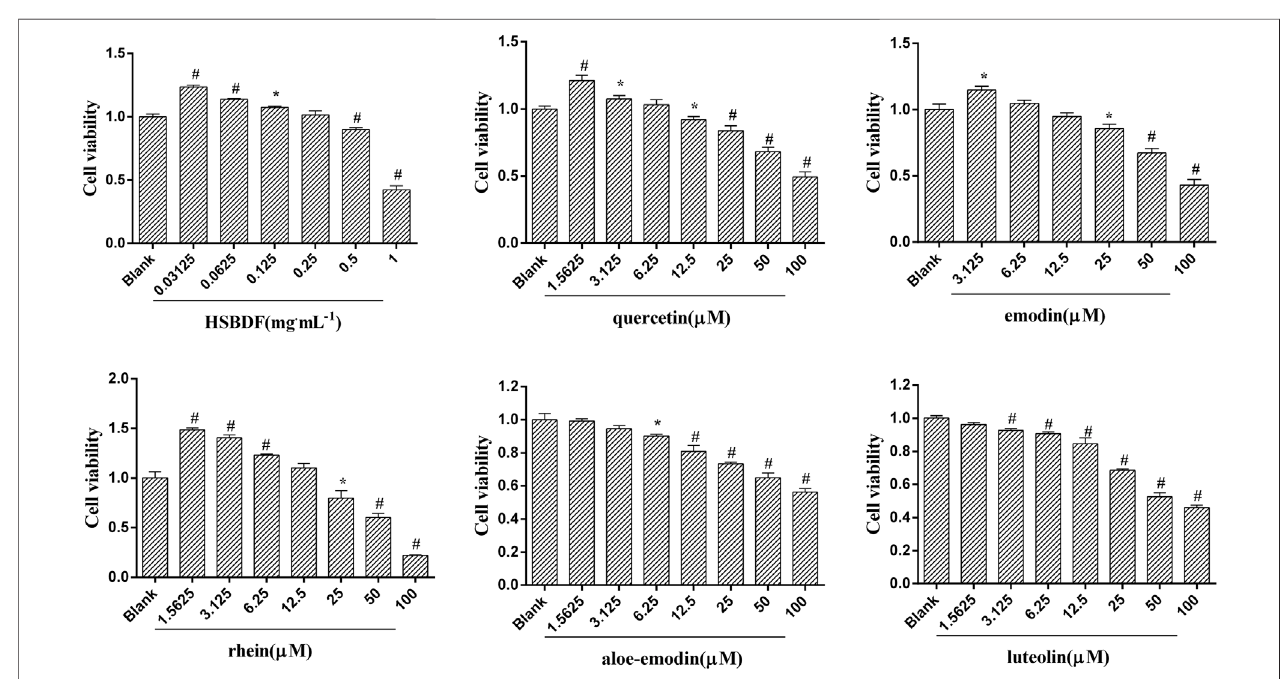
FIGURE 4 | Cell viability after treatments of HSBDF and key compounds in plasma. (cell viability was detected by CCK-8; * p < 0.05, # p < 0.01 versus blank).